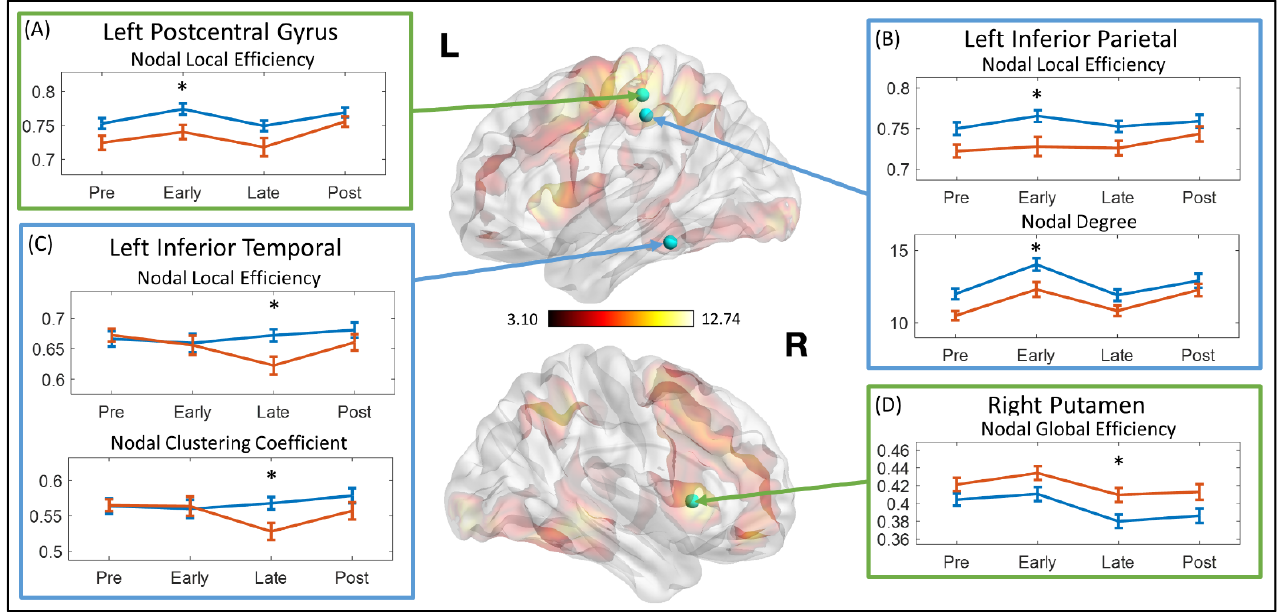
Figure 2. Mean network topological properties at different stages. The topological properties that showed significant group difference were marked with asterisk (*). ( A ) Mean nodal local efficiency at left postcentral gyrus. ( B ) Mean nodal local efficiency and mean nodal degree at left inferior parietal gyrus. ( C ) Mean nodal local efficiency and mean nodal clustering coefficient at left inferior temporal gyrus. ( D ) Mean nodal global efficiency at right putamen. L: left hemisphere; R: right hemisphere; Pre: pre-stimulation stage; Early: early stimulation stage; Late: late-stimulation stage; Post: post-stimulation